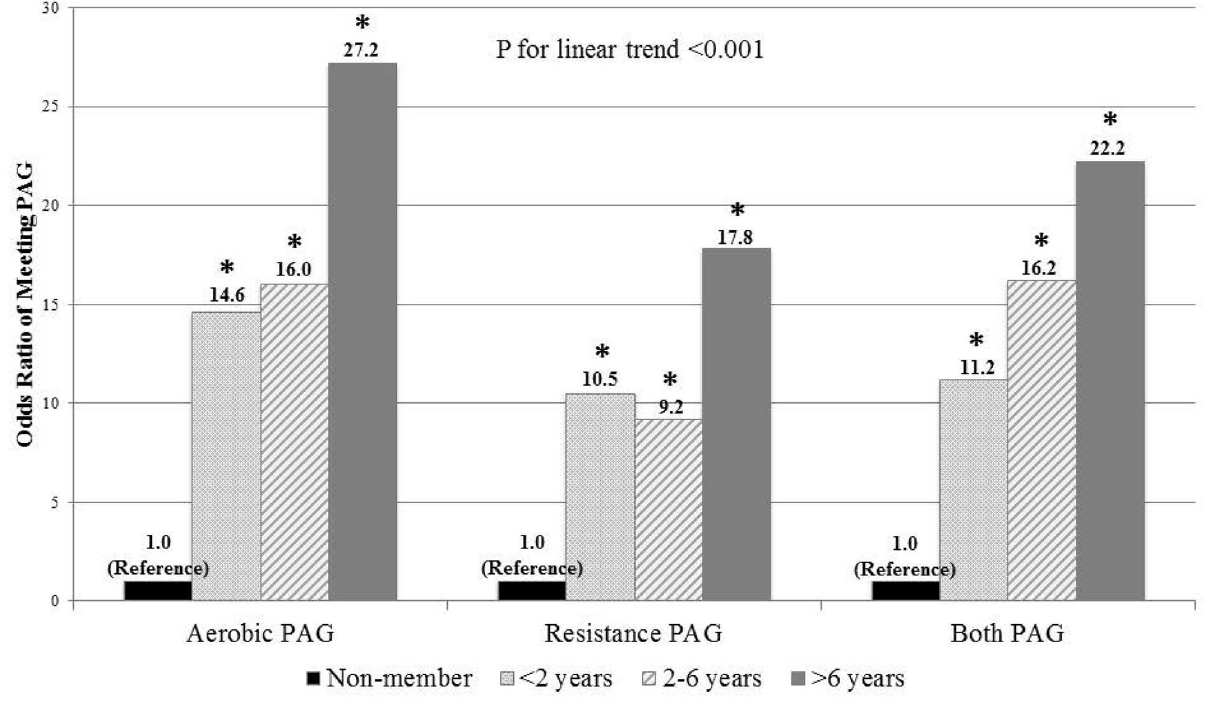
Fig 1. Odds ratios of meeting physical activity guidelines (PAG) by length of health club membership using total physical activity. The reference category for all analyseswas non-healthclub members. All analyseswere adjustedfor age, sex, and body mass index. * indicatessignificantly different from the reference category, p < 0.05.Odds ratios (95% confidenceintervals) were 14.6 (6.9–30.9), 16.0 (7.2– 35.7), and 27.2 (10.3–72.0)in meetingthe aerobic PAG, 10.5 (5.1–21.4), 9.2 (4.5–18.7), and 17.8 (7.2–43.9)in meetingthe resistancePAG,